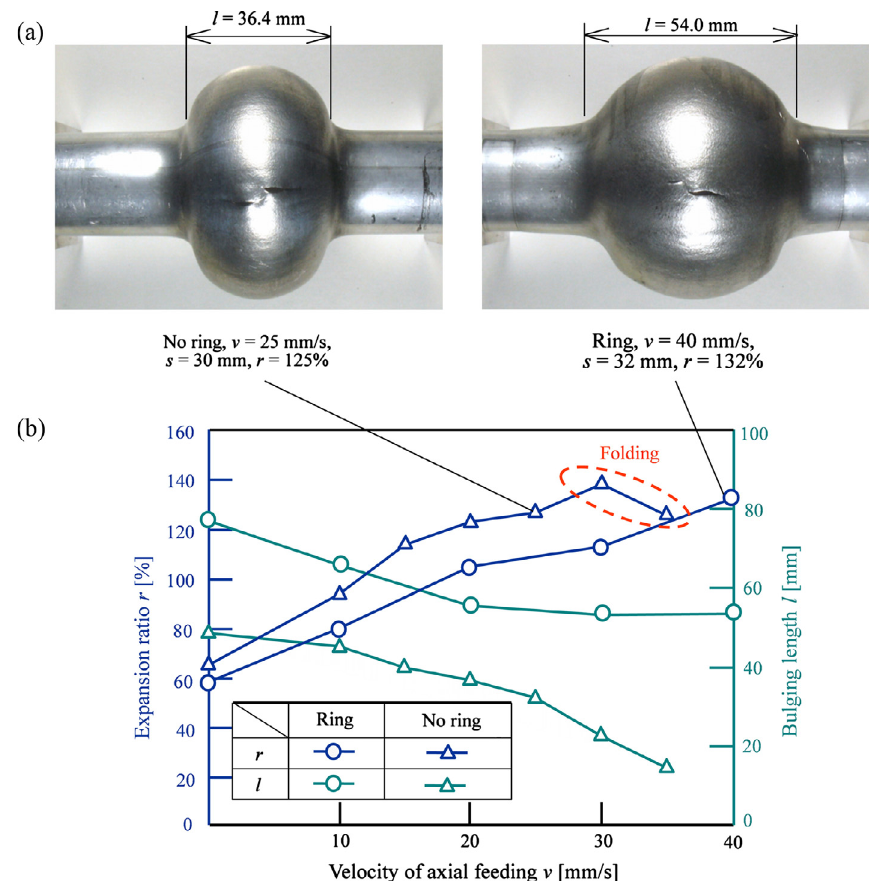
Figure 14. (a) Burst tubes with and without stainless steel ring and (b) variations in expansion ratio and bulging length with velocity of axial feeding for J = 76 A/mm 2 , p 0 = 0.8